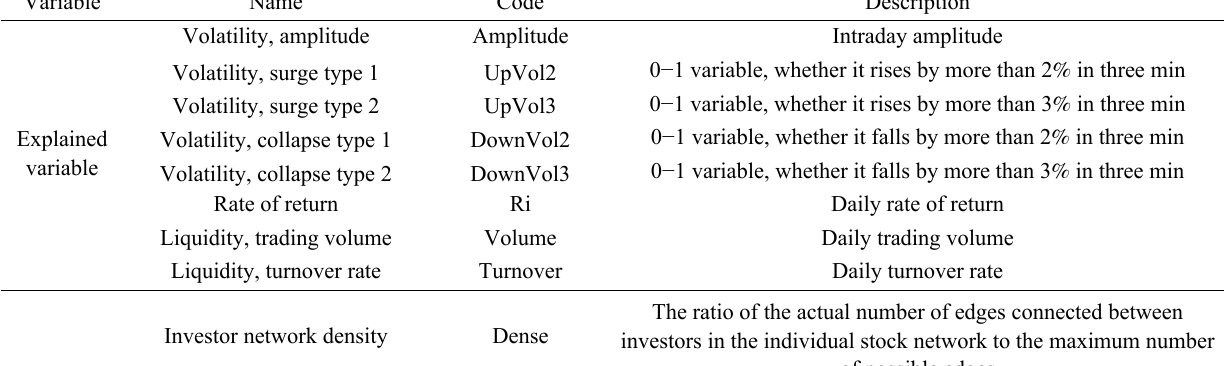
Table 11 Description of the variables of the investors social network and asset